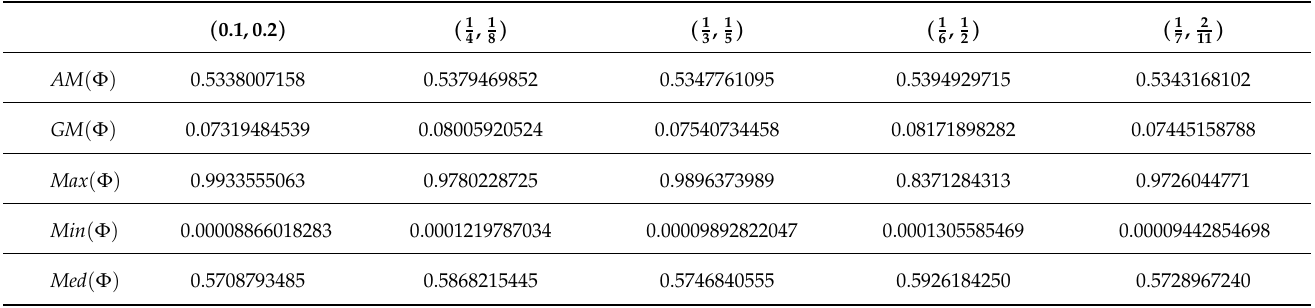
Table 1. The values of the aggregation